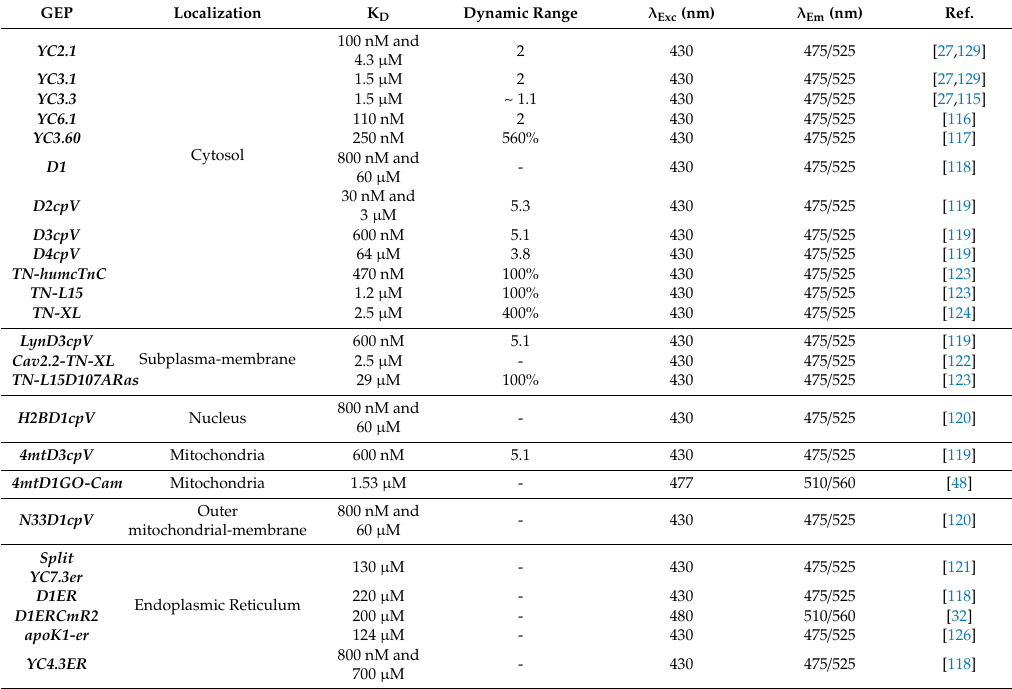
Table 3. Selection of FRET-based GEPs suitable for subcellular Ca 2 +